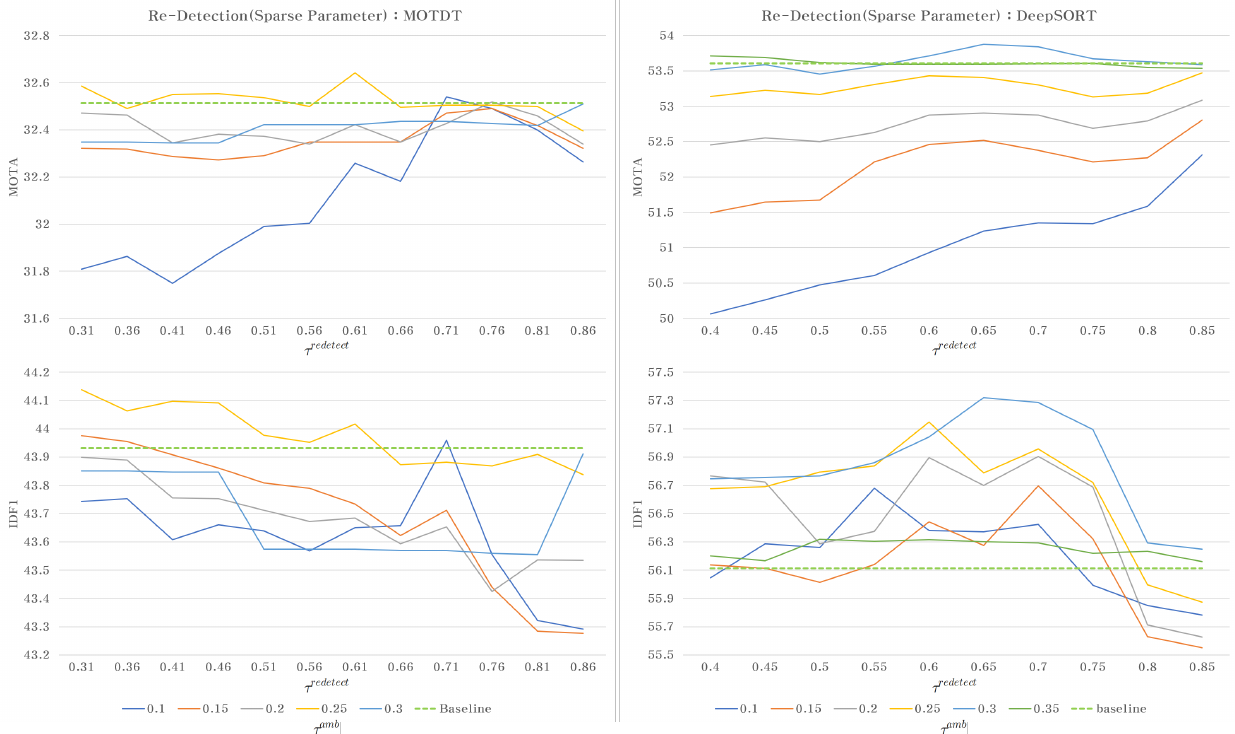
Figure 10. The results of the first experiment varying τ redetect and τ amb in 0.05 units. The vertical and horizontal axes represent the MOTA and IDF1 score and τ redetect , respectively. Specifically, the green dotted line and the multiple colors of other lines represent the baseline performance and each τ amb ,